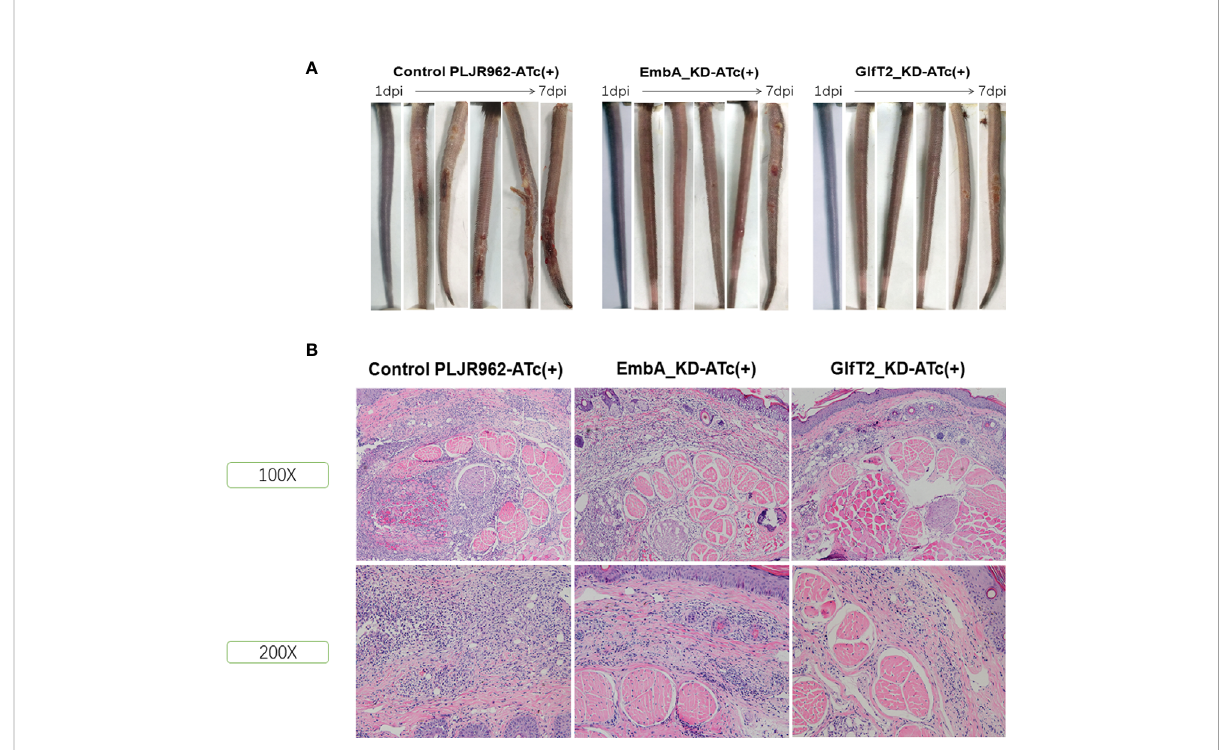
FIGURE 5 Murine tail infection model with EmbA/GlfT2_KD strains. (A) Tail ulcer formation in mice injected with control PLJR962 strain and EmbA/ GlfT2_KD strains within 1 week post-injection. (B) Pathological H&E staining in mice ulcer. With distinguishable tail tissue cells, most of the clustered purple nuclei belong to